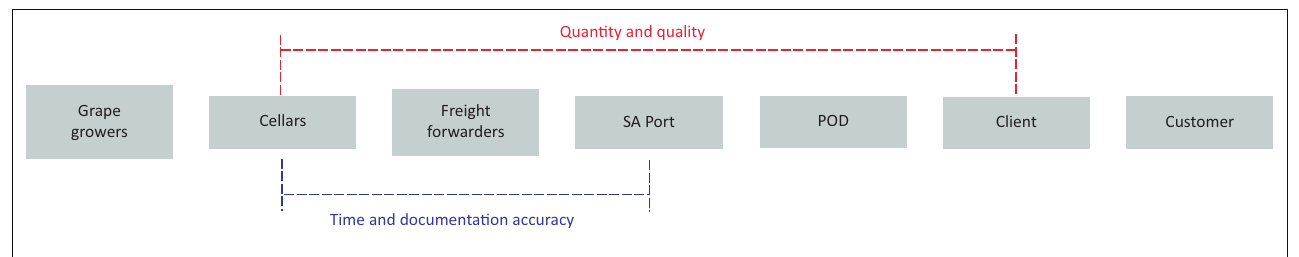
FIGURE 3: Cellars’ responsibility regarding